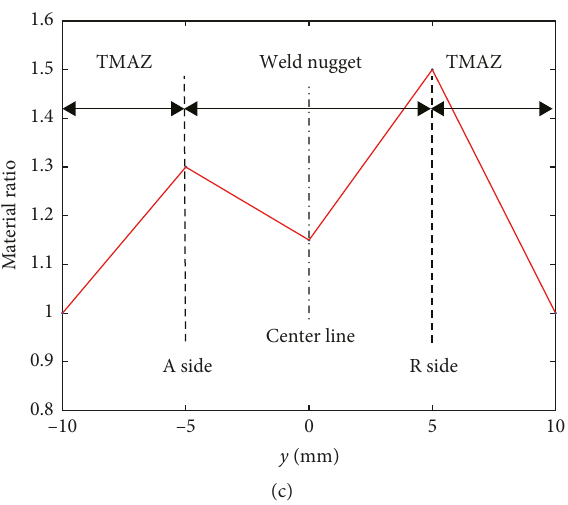
Figure 10: Material ratios of specimens with welding direction heading to left. (a) c , s